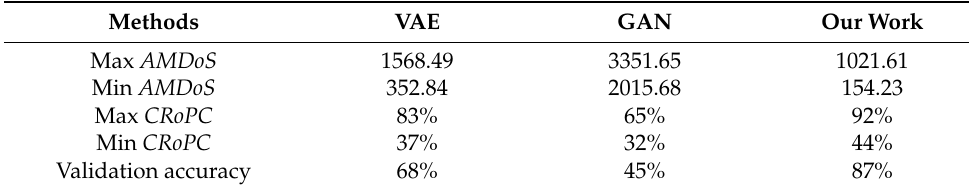
Figure 10. Comparison with the model of VAE, GANs and our work. ( a ) Geological background of the selected result; ( b , c ) input sections; ( d ) comparison of the sections generated by the three models and label. Table 4. Effect evaluation of different